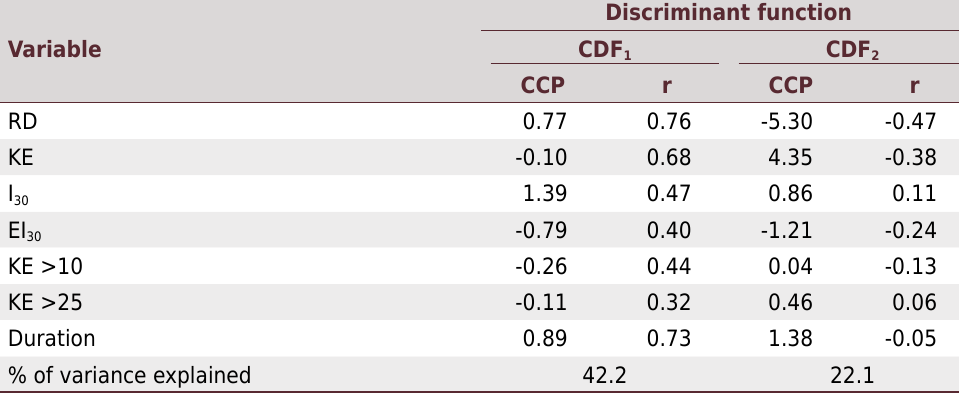
Table 4. Standardized canonical coefficients (SCC) and correlation coefficients (r) between the first canonical discriminant functions (CDFs) and the seven variables